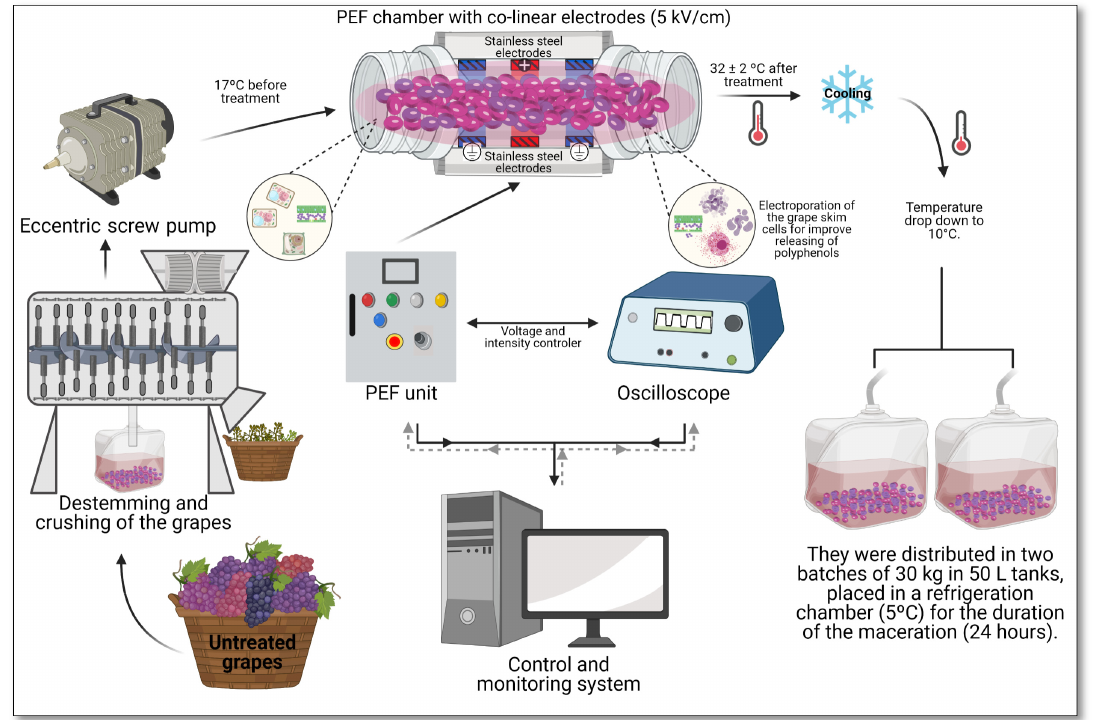
Figure 1. Schematic of pulsed electric fields PEF processing of grapes.